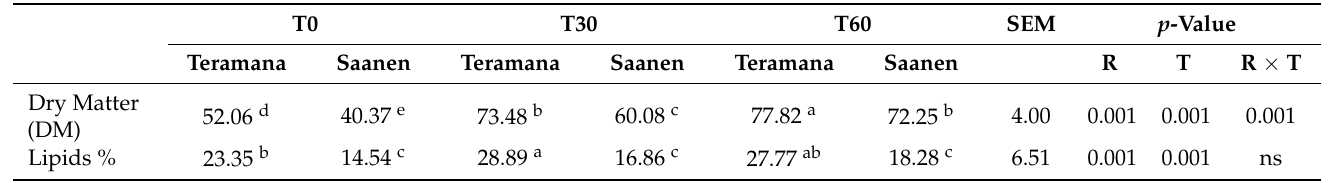
Table 2. Chemical composition of cheese at 0 (T0), 30 (T30), and 60 (T60) days of ripening, obtained from the milk of two goat breeds: Teramana and Saanen.